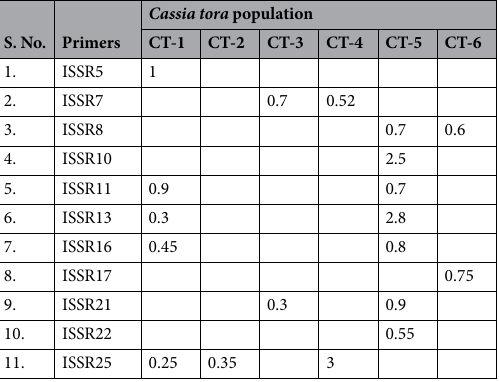
Table 2. Specific authentication bands (kb) from six C. tora populations.